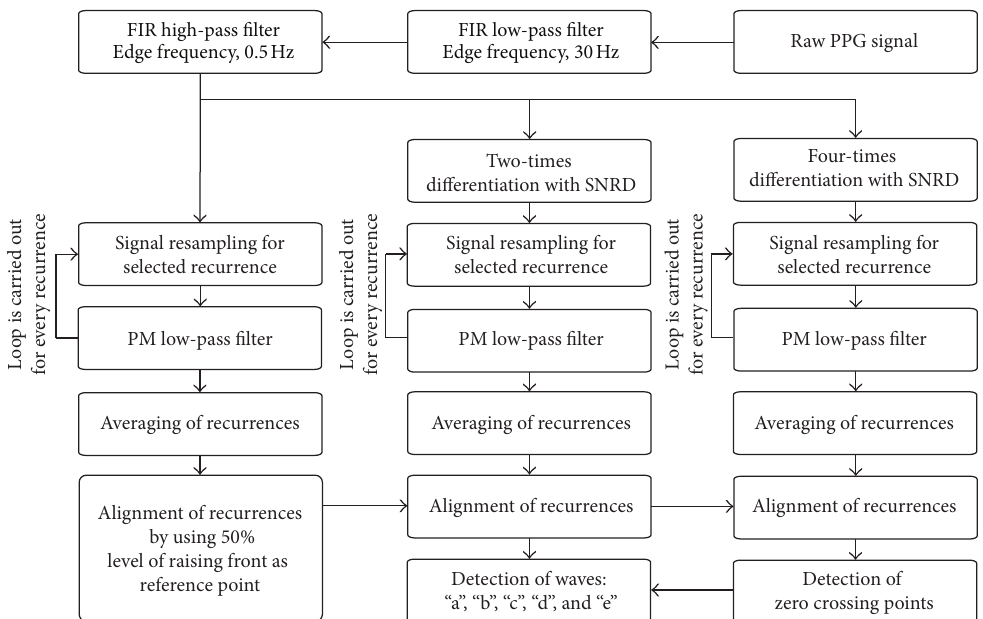
Figure 3: Block diagram of the signal processing for the second derivative